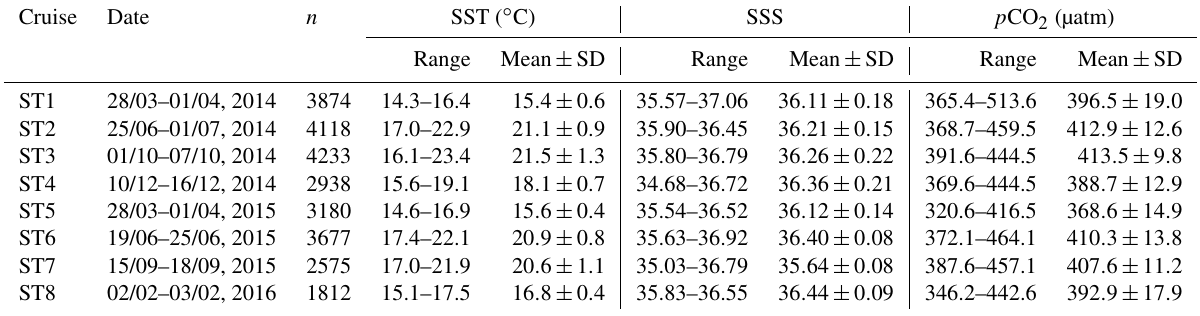
Table 1. Date, number of measurements ( n ), range, average values, and standard deviation of underway sea surface temperature (SST), sea surface salinity (SSS), and p CO 2 during the eight cruises undertaken: March 2014 (ST1), June 2014 (ST2), October 2014